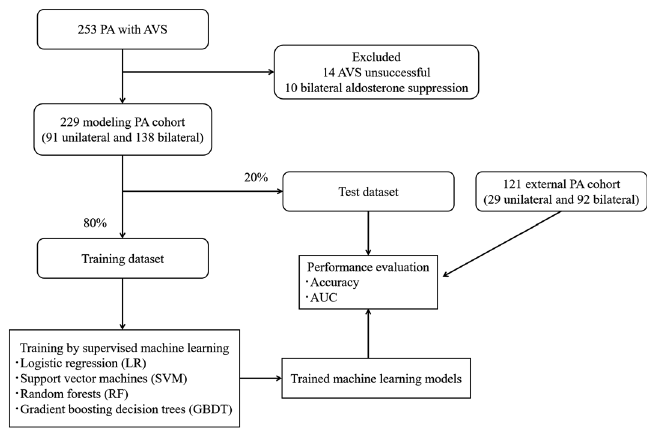
Figure 1. The supervised machine learning workflow of this